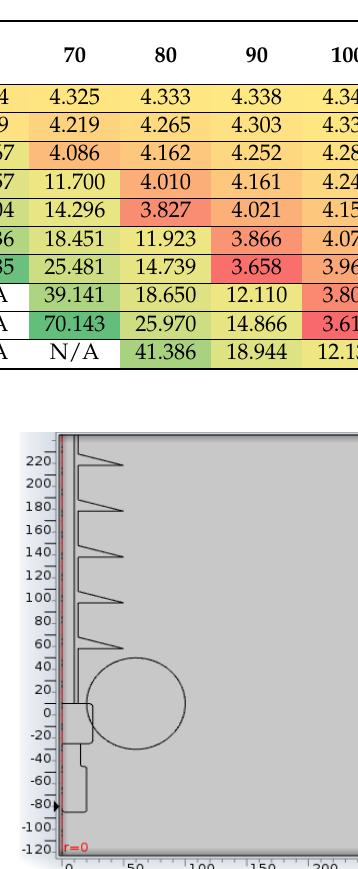
Table 4. Results of electric field distribution on 132 kV insulator string with the variation in R : H = 0 and r from 5 mm to 50 mm.